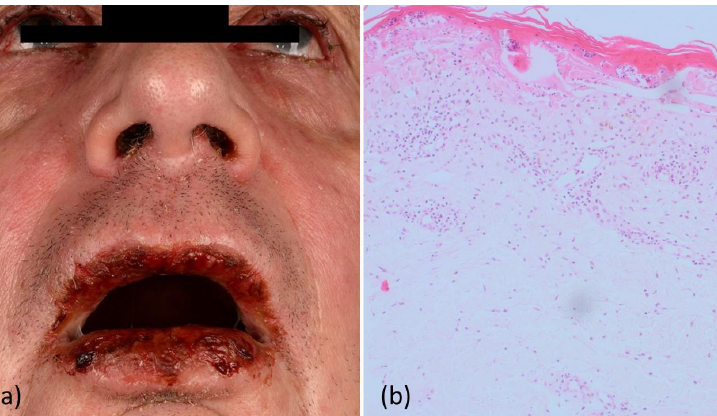
Figure 1. ( a ) Blepharo-conjunctivitis, together with bloody and crusty erosions on the lips and nostrils, ( b ) a punch biopsy of a macular lesion on the left arm, showing vacuolar interface dermatitis with focal necrotic alteration of the epidermis and an abundance of dyskeratoses. Of note, acantholysis was not observed.